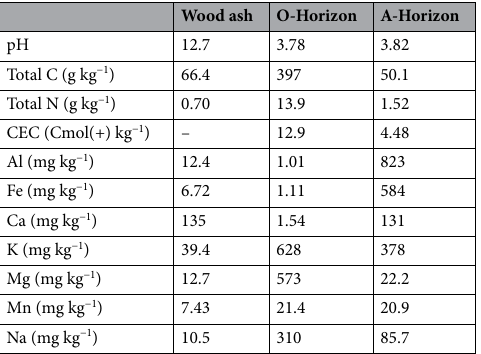
Table 3. Physicochemical composition of the applied wood ash and the used O- and A- horizon soil. All metal concentrations are total concentrations following acid digestions and subsequent ICP-MS. Presented values represents averages (n = 3). Data are extracted from Hansen et al 33 . and Maresca et al 27